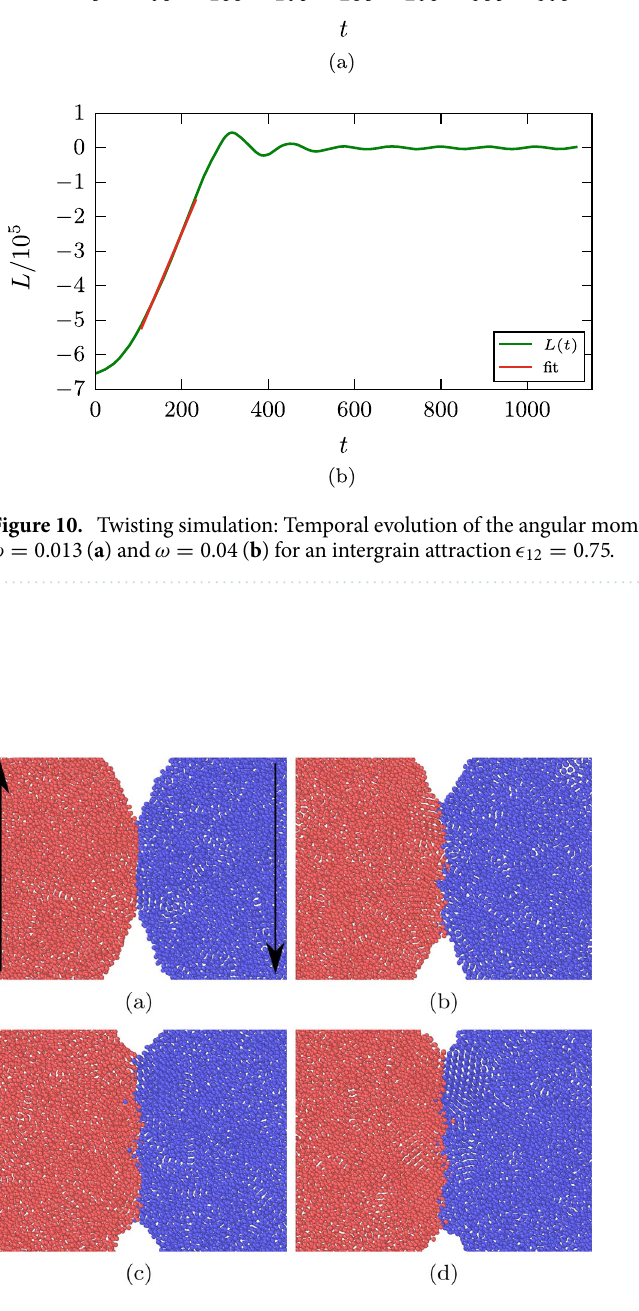
Figure 11. Snapshots of a twisting simulation with ǫ 12 = 0.75 for an initial value of the angular velocity ω = 0.04 . Snapshots ( a , b , c , d ) are spaced by (cid:31) t = 74.2 . The arrows in ( a ) indicate the rotation direction, see Fig. 1b. In all subpanels, the grains are aligned such that the central axis lies horizontally in the middle of the